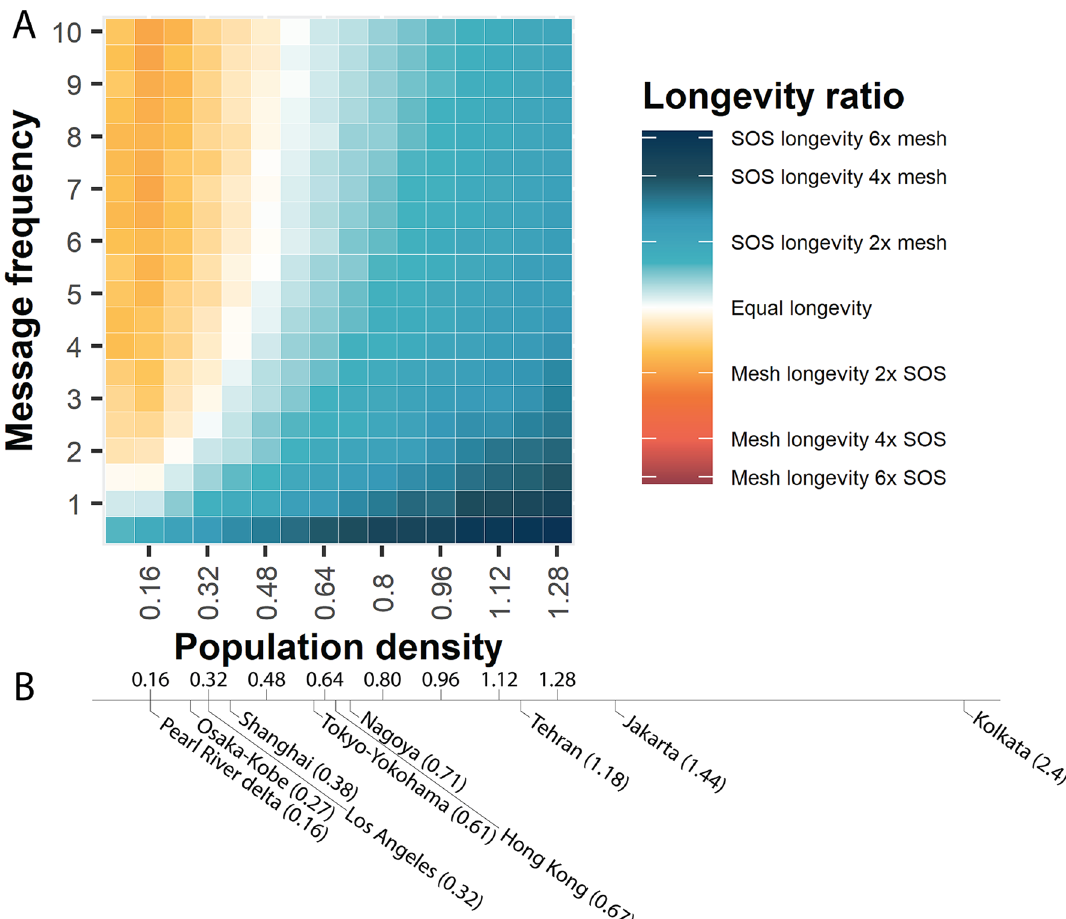
Figure 2. ( A ) Phase diagram of the difference in longevity between mesh and SOS, for varying message frequency and population density. Light blue to deep blue indicates an increasing advantage for SOS over mesh. Orange to red indicates an increasing advantage for mesh over SOS (dark red not occurring). White indicates that longevity was equal between the two. SOS performs best when population densities are higher (towards the right) or message frequencies are lower (towards the bottom). Mesh performs best when population densities are low and message frequencies are high. ( B ) Top ten cities (and their density) in the world that have the highest risk of getting affected by natural